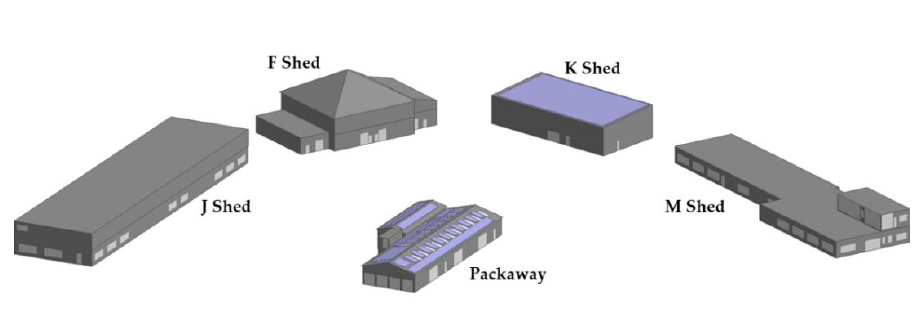
Figure 3. Simulation models of the buildings in the Milford Haven